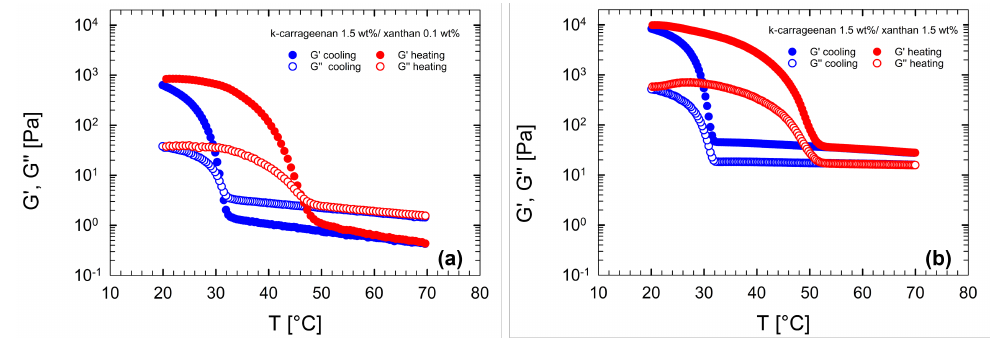
Figure 7. Viscoelastic moduli as a function of temperature, for κ -c/XG solutions at 1 ◦ C/min: ( a ) κ -c 1.5 wt% and XG 0.1 wt%, and ( b ) κ -c 1.5 wt% and XG 1.5 wt%.